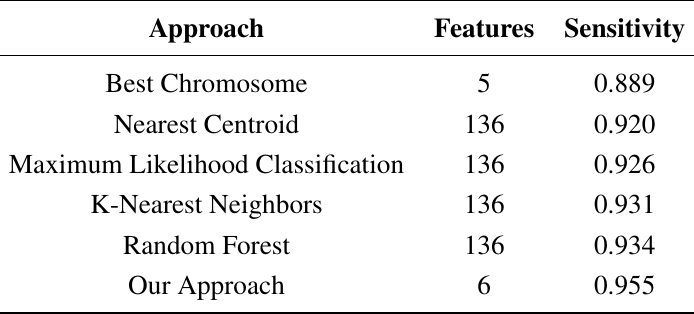
Table 5. Comparison of different